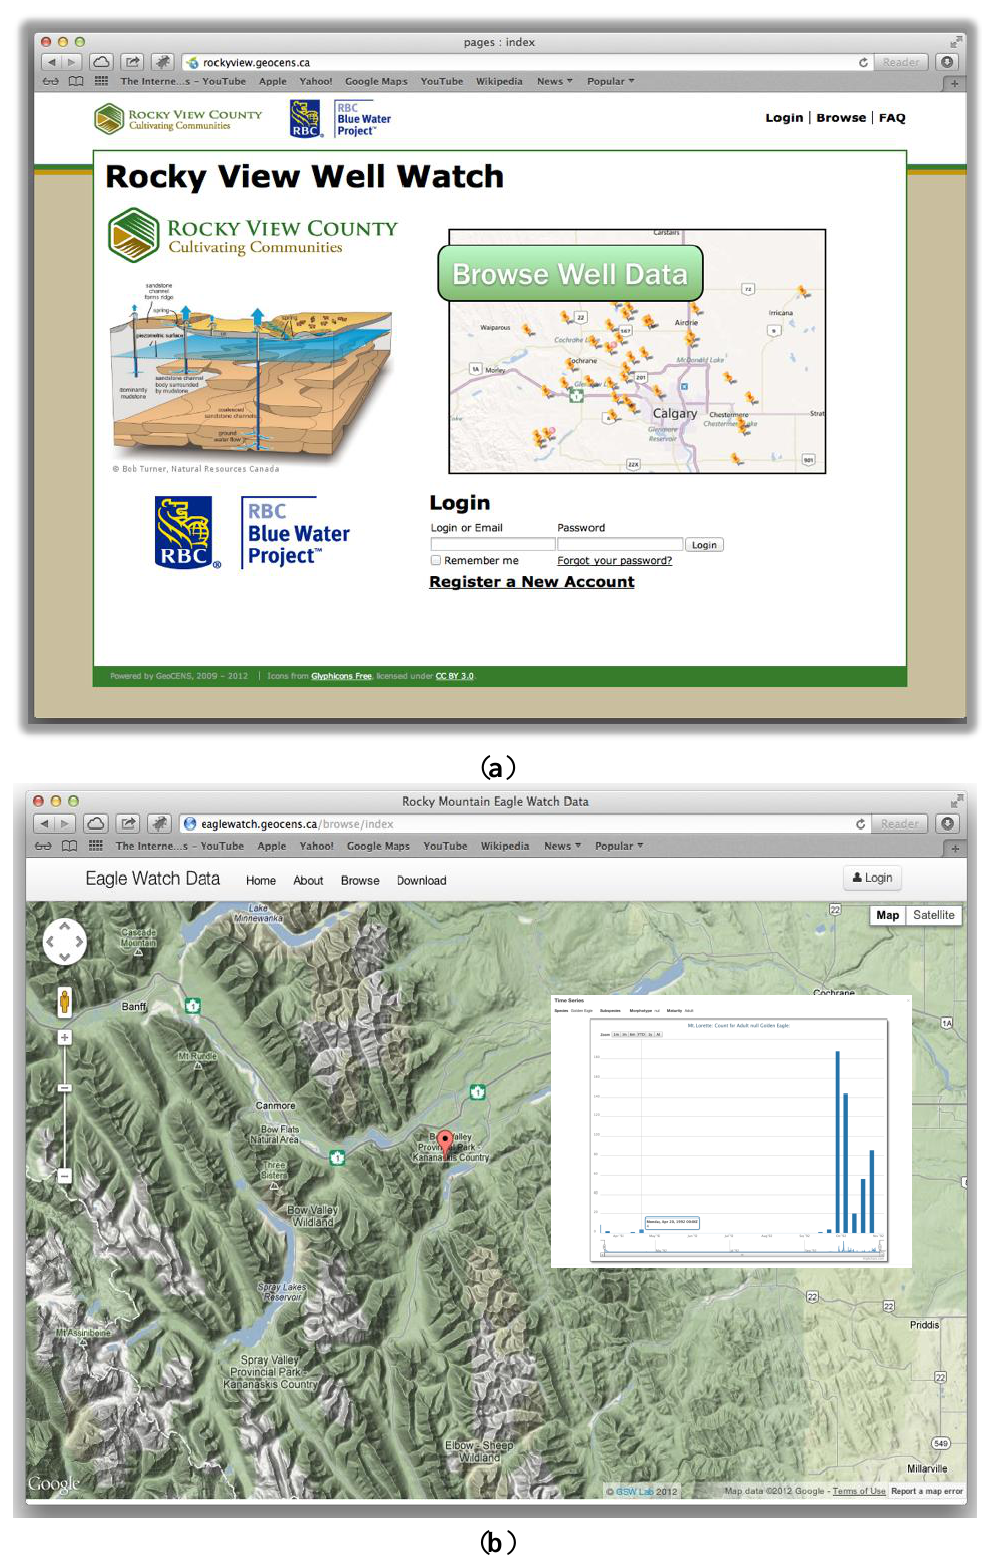
Figure 9. Screenshots of ( a ) Rocky View Well Watch, ( b ) Rocky Mountain Eagle Watch, and ( c ) Real-time In-Situ Monitoring for Agriculture (RISMA)